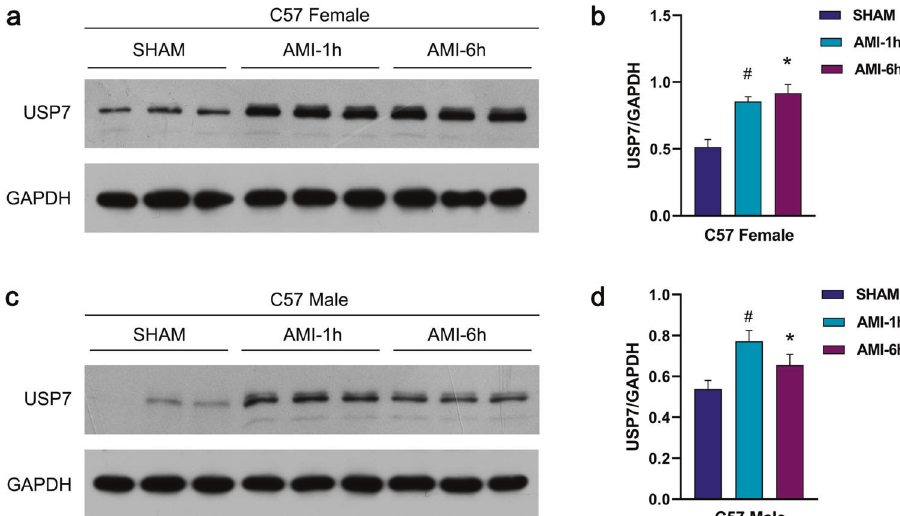
Fig. 1 Expression of USP7 in myocardial infarction. a , b The expression of USP7 in female mice after AMI detected using a Western blot. c , d The expression of USP7 in male mice after AMI detected using a Western blot. # P < 0.05, mean standard deviation ( n = 3), compared to the SHAM group. * P < 0.05, mean standard deviation ( n = 3), compared to the SHAM